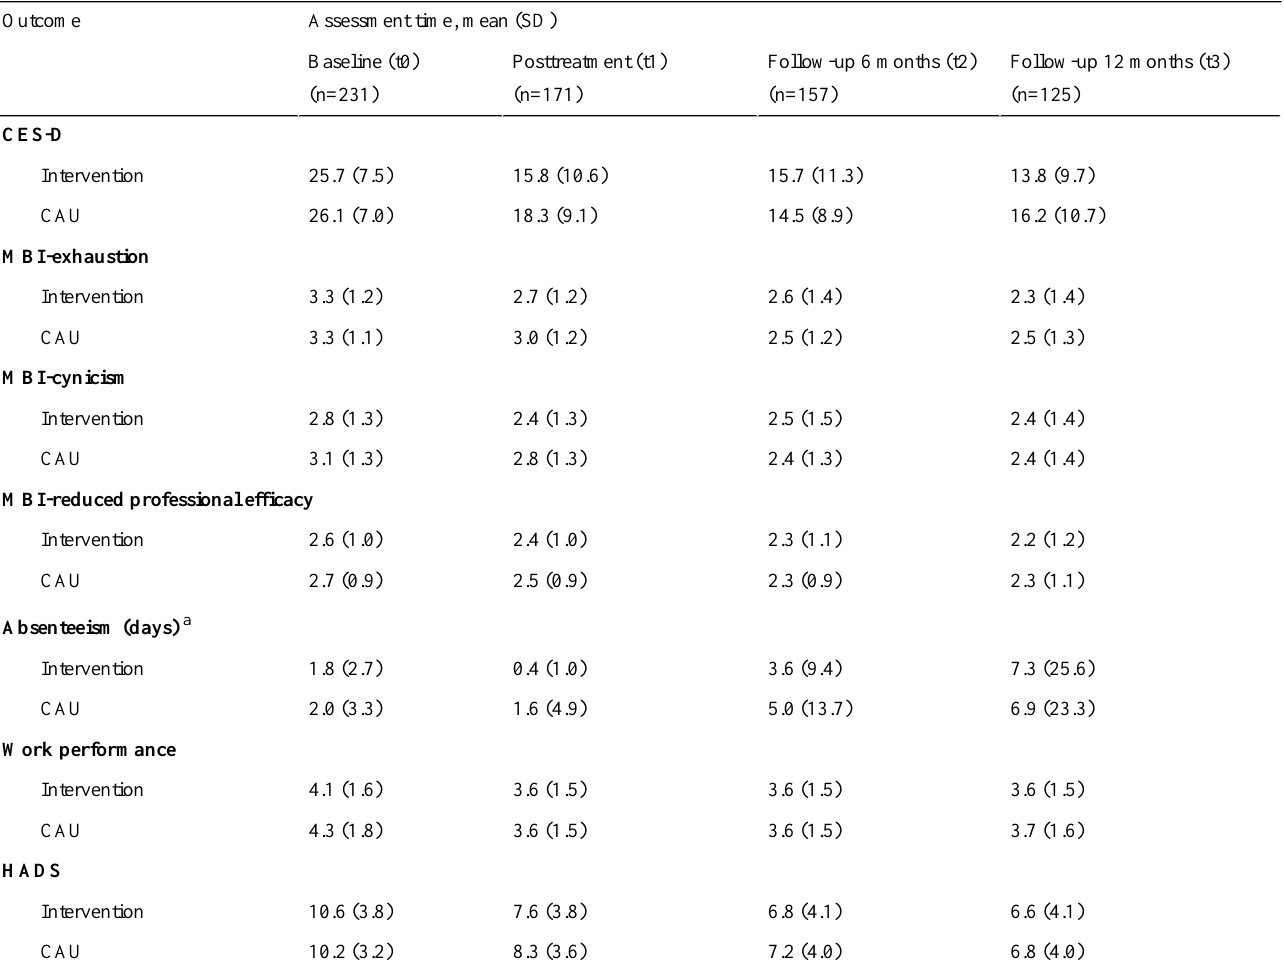
Table 2. Observed scores of the intervention and care-as-usual (CAU) groups on different outcome measures. Assessment time, mean